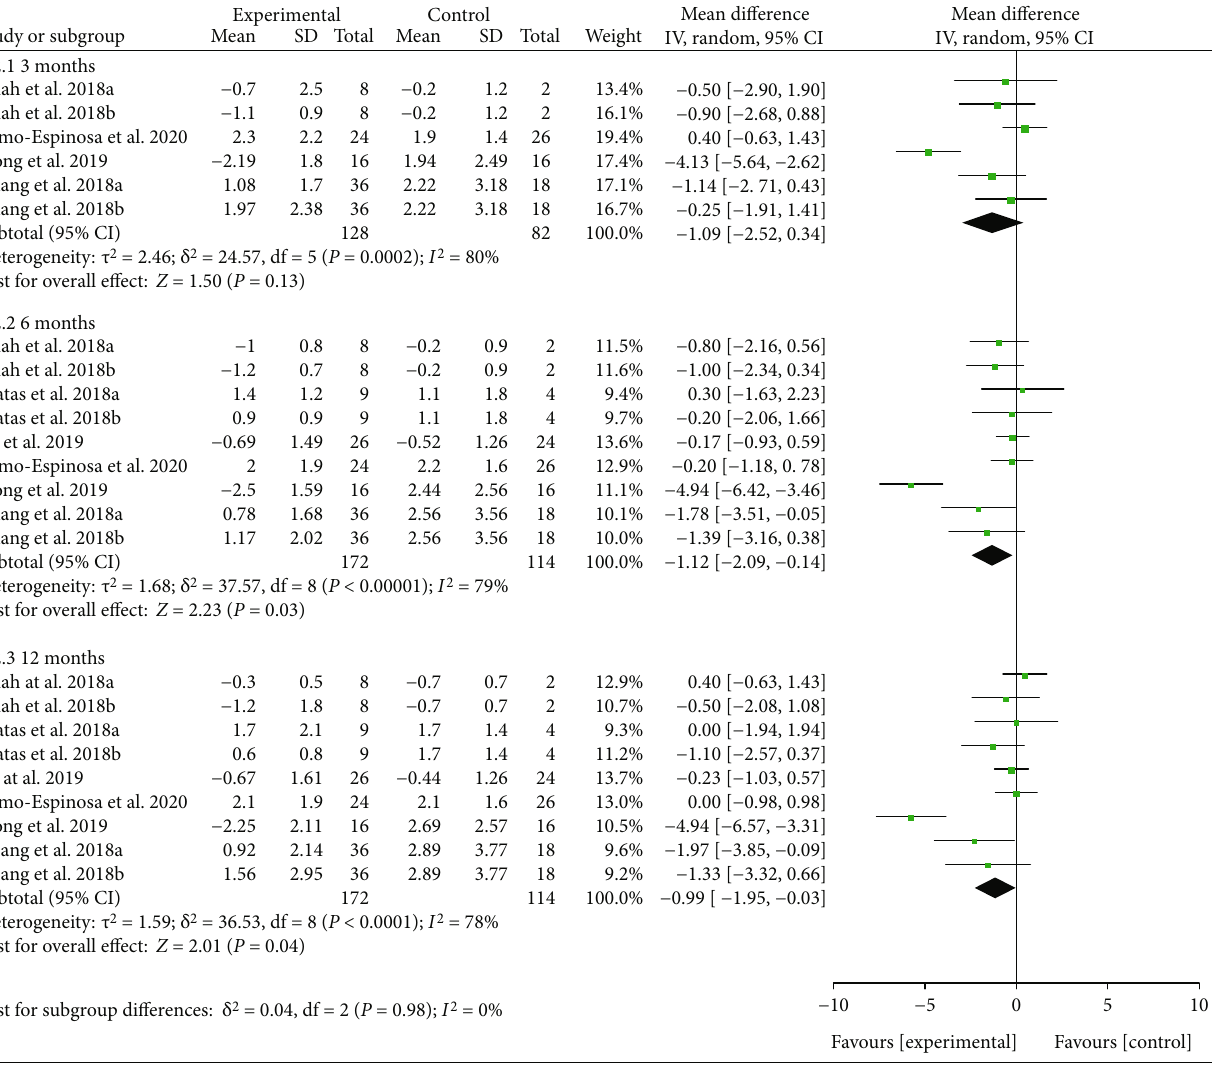
Figure 6: WOMAC sti ff